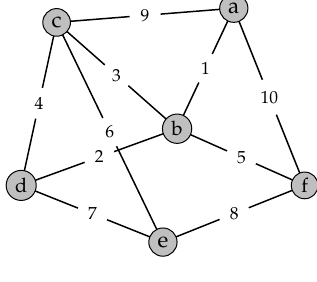
Figure 1. A network with 10 links, and six